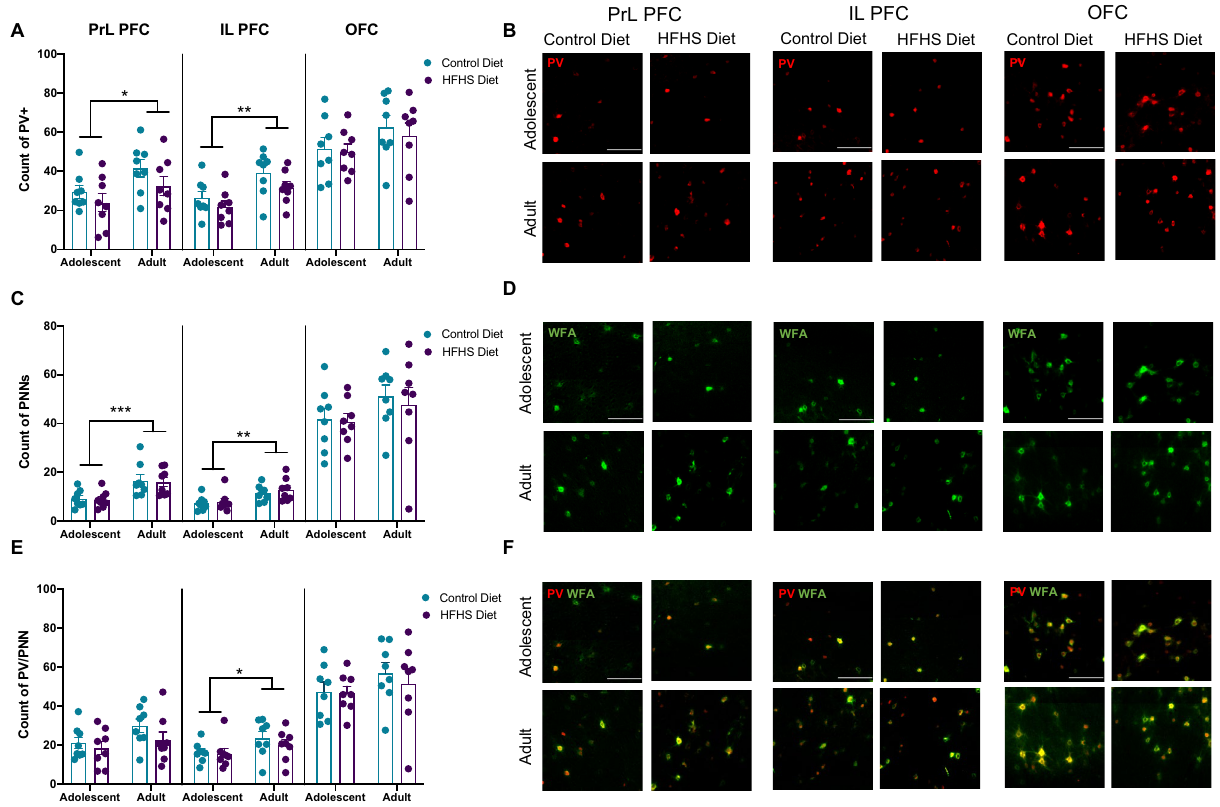
Figure 2. Developmental changes to PV and PNN populations within frontal cortical subregions. Mice in the adult cohort had significantly greater numbers of ( A , B ) PV+ neurons and ( C , D ) PNNs in the PrL and IL PFC, however no age differences were observed in the OFC. There were significantly more PV/PNN colocalised neurons in the adult cohort ( E , F ) in the IL. Data were assessed using two-way ANOVAs * p < 0.05, ** p < 0.01. Representative photomicrographs were taken at 40X magnification (red—parvalbumin, green—WFA + PNN), scale bars show 100